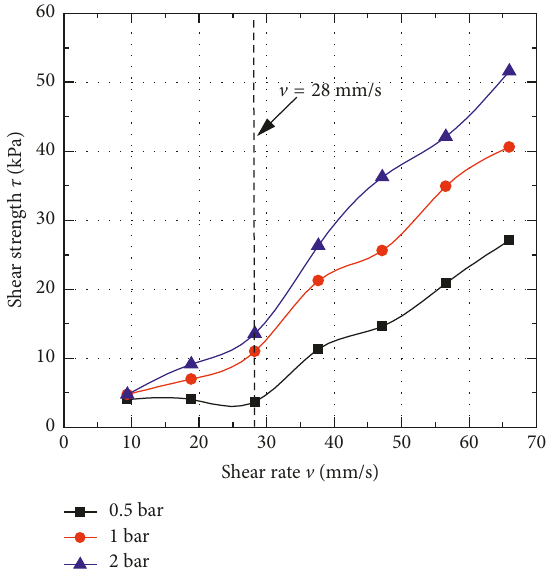
Figure 8: Effect of shear rate of the test device on shear strength of standard